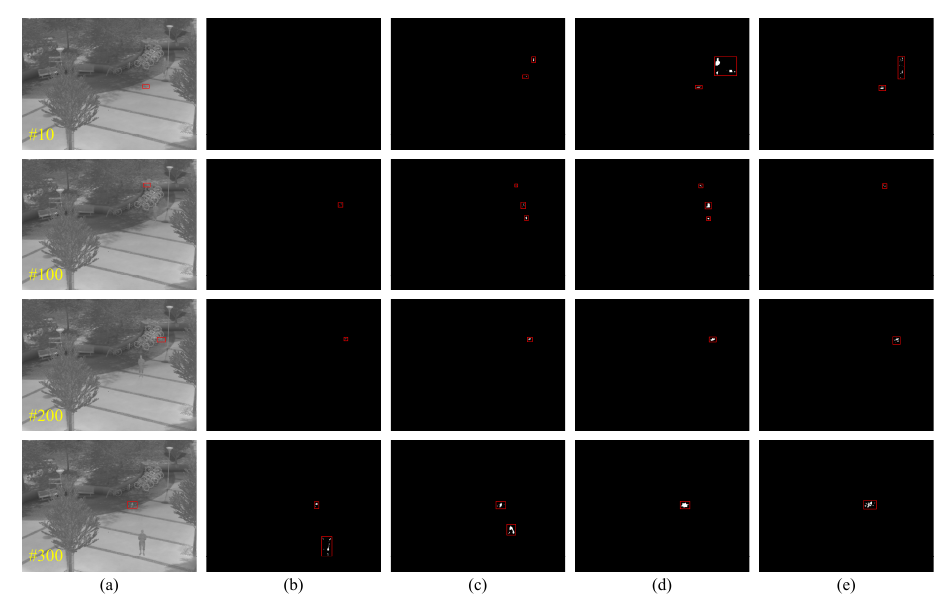
Figure 6. Some experiment results of flying small target detection on infrared image sequence obtained from different algorithms ( a ) groundtruth, ( b ) GMMv1, ( c ) GRASTA, ( d ) DECOLOR and ( e ) the proposed method.